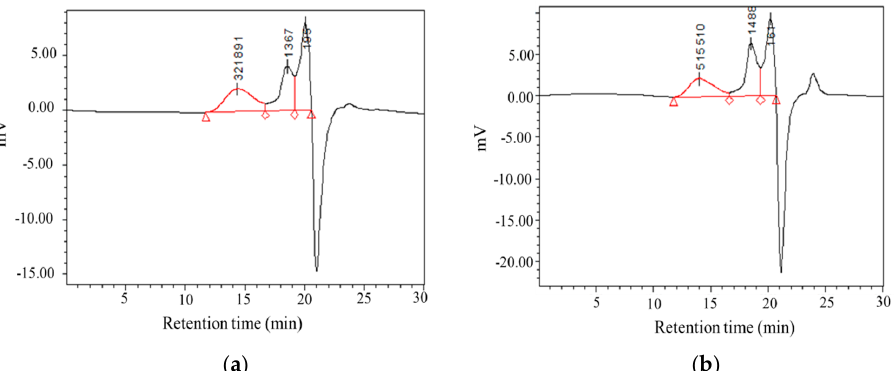
Figure 4. Gel permeation chromatography (GPC) spectrums of C. morifolium polysaccharides. ( a ) CMP-H; ( b ) CMP-U. CMP-H: C. morifolium polysaccharides obtained by hot reflux extraction; CMP-U: C. morifolium polysaccharides obtained by ultrasonic assisted extraction. Table 4. Molecular weight distribution of CMP-U and CMP-H.